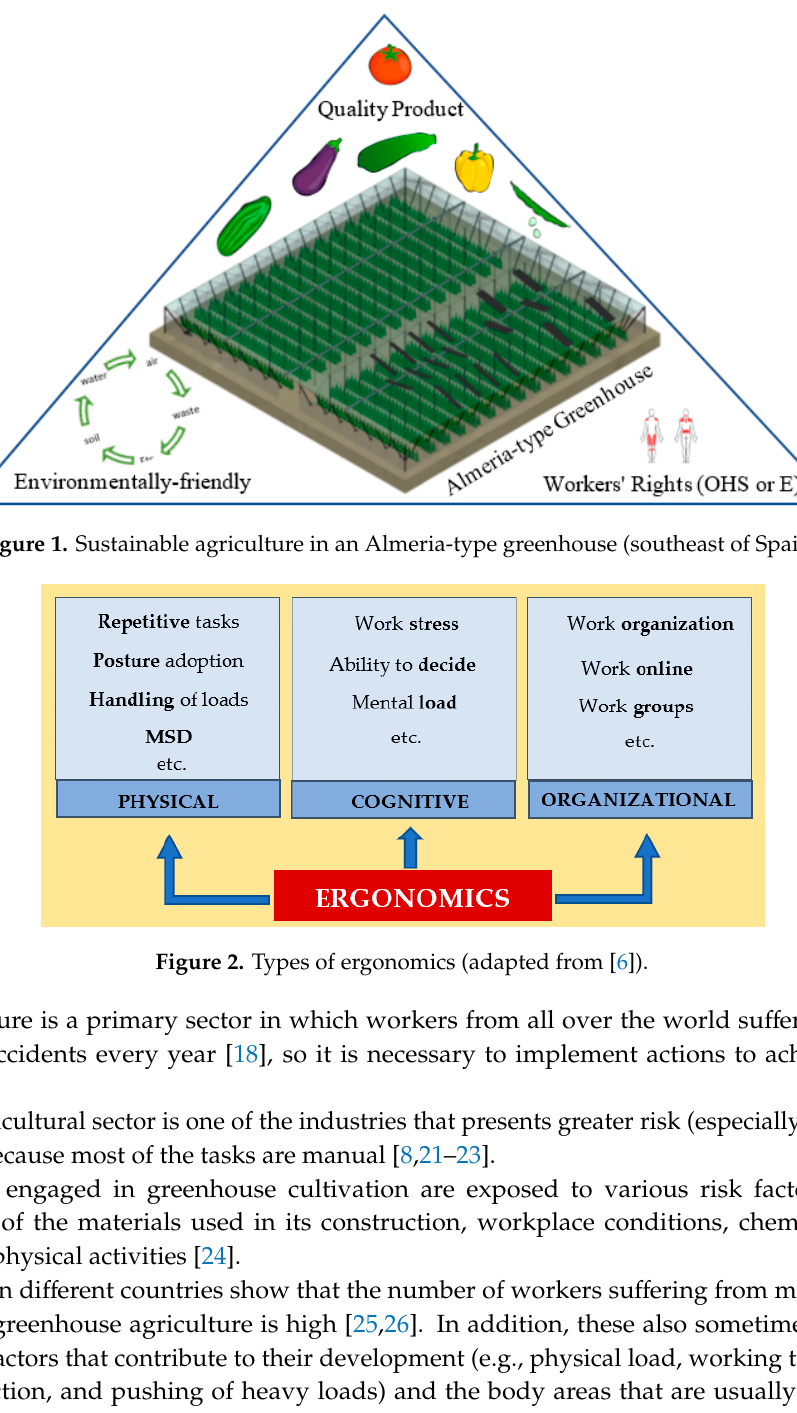
Figure 2. Types of ergonomics (adapted from [6]).